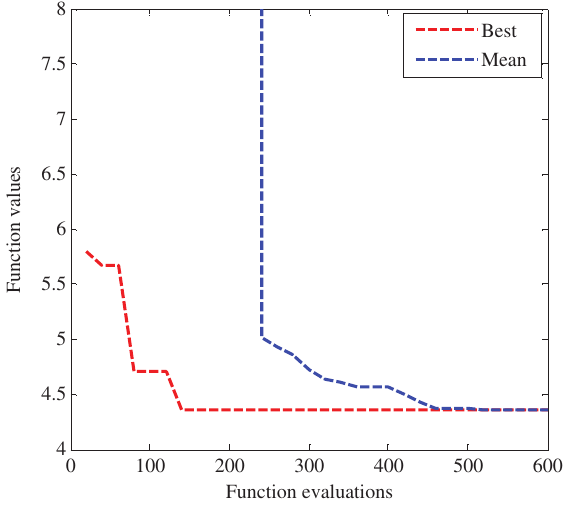
Figure 3: Convergence Graph of Best and Mean Values of Objective Function for Welded Beam Design. Table 1: Optimum Designs of the Welded Beam.